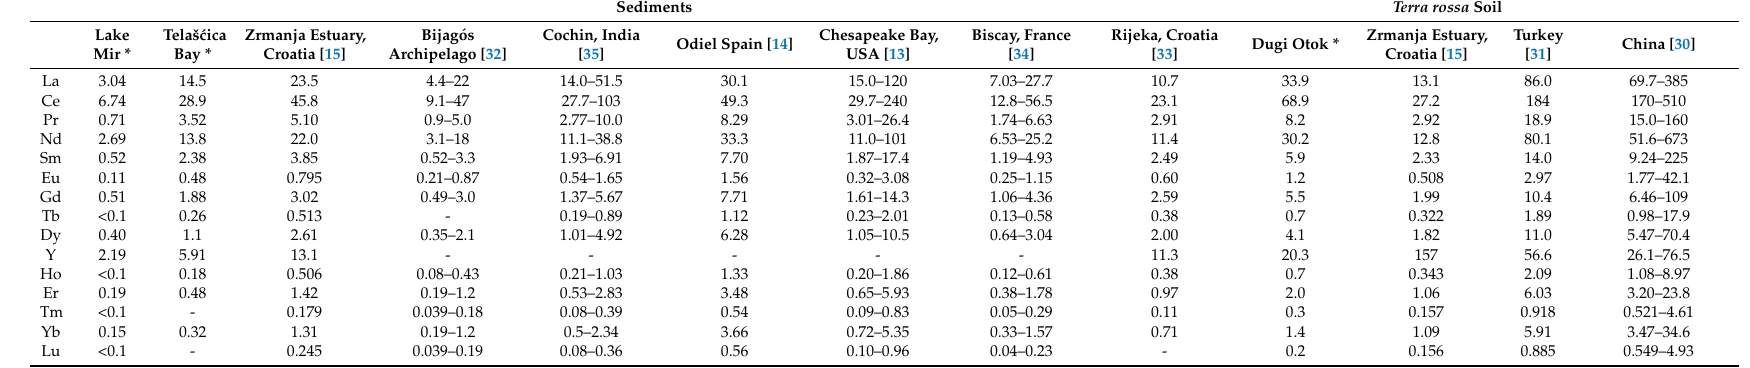
Table 3. Comparison of average REY concentrations in the studied lake and bay sediments and local soils with literature data, expressed in mg kg − 1